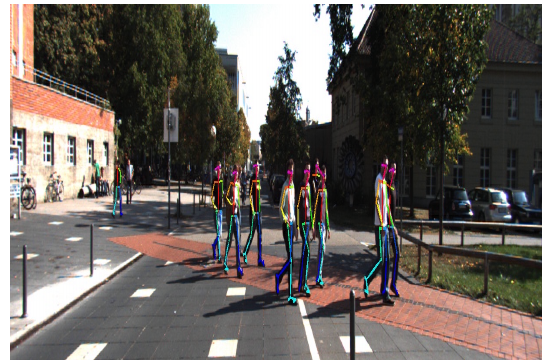
Figure 5. Result of OpenPose joints detection.The training sequences number 16 of the KITTI tracking